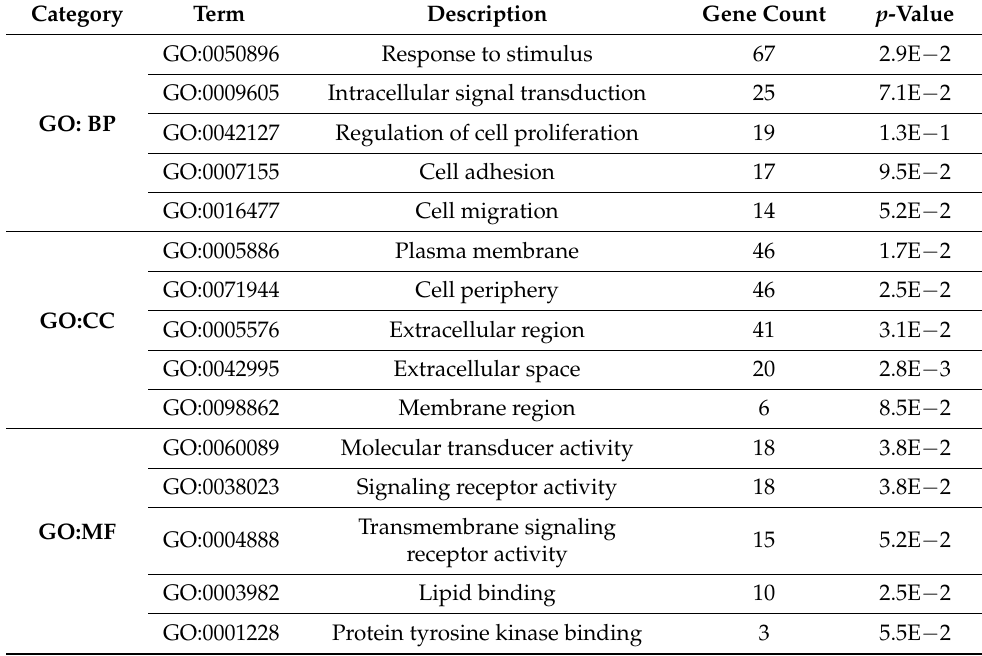
Table 1. Gene ontogeny enrichment analysis of differentially expressed